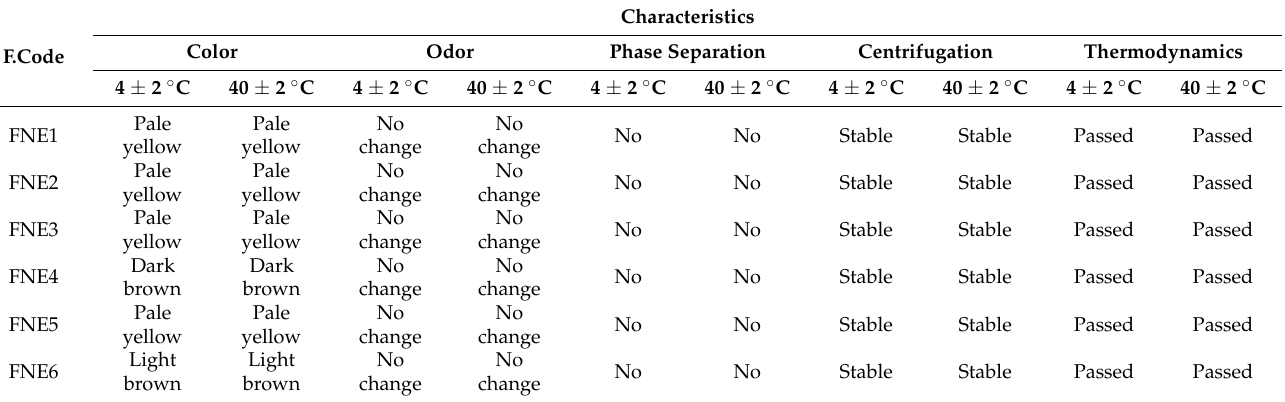
Table 1. Thermodynamics stability analysis of nanoemulsion formulations (FNE1-FNE6).